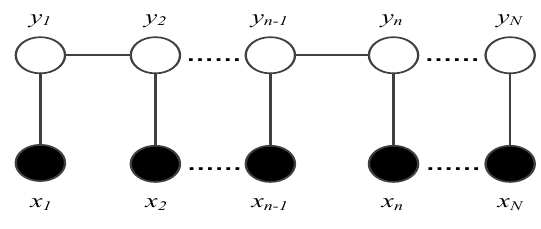
Fig. 1. Structure of linear chain